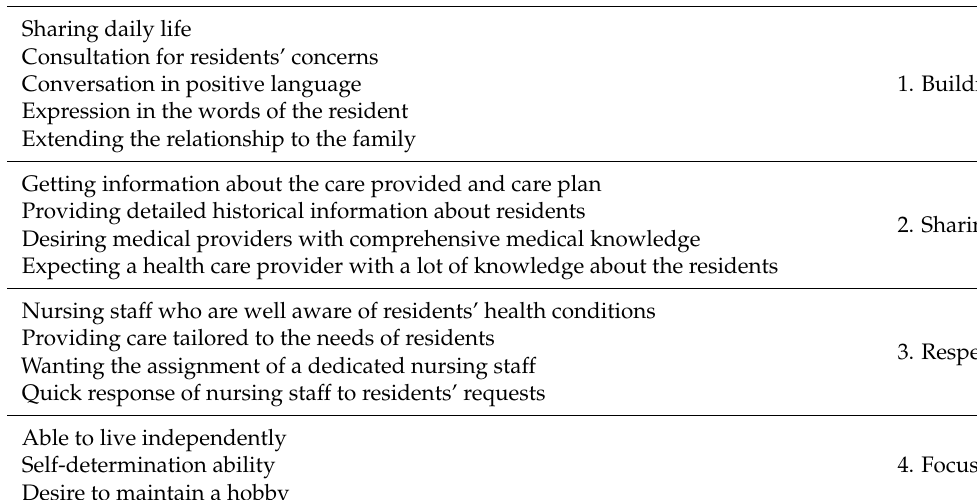
Table 3. Synthesized themes of nursing home residents’ experience of person-centered care. Key Concepts from First, Second-Order